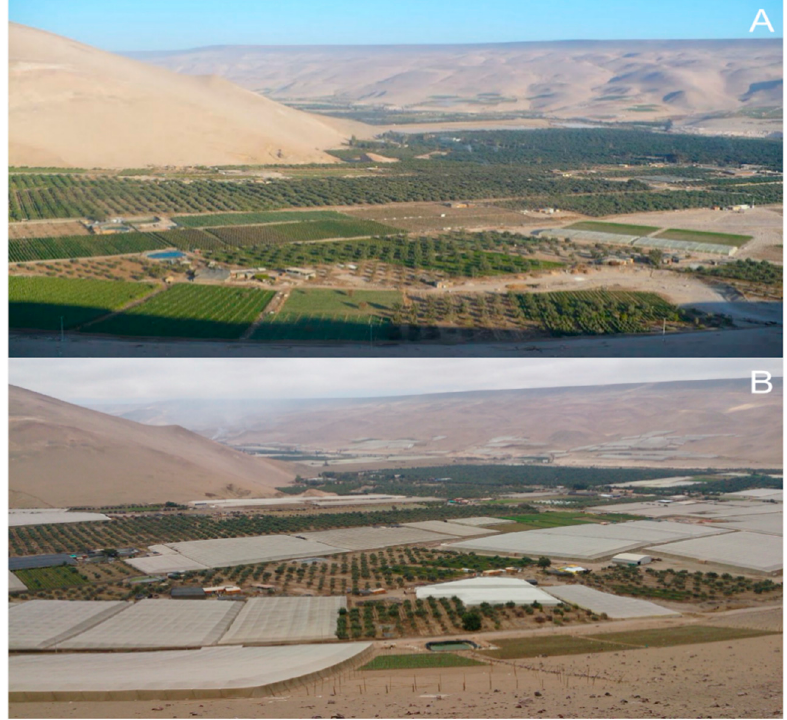
Figure 3. Evolution in adopting tomato cultivation under exclusion screens in Valle de Azapa, north of Chile, between years 2009 ( A ) and 2019 ( B ).